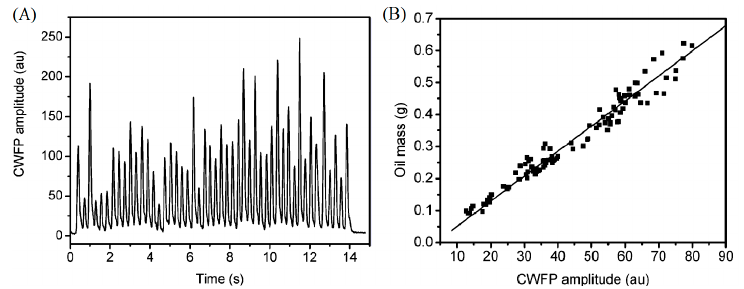
Figure 6. ( A ) CWFP signal amplitude corresponding to 48 macadamia nut fragments with oil masses ranging from 0.1 to 0.7 g. ( B ) Oil mass as a function of CWFP peak amplitude for macadamia nut fragments with oil masses ranging from 0.1 to 0.7 g. A total of 96 peaks were obtained in a time of Copyright (2007), with permission from ACS Publications. 14 s. The linear regression determination coefficient was R 2 = 0.95. Adapted from Publication [32], Copyright (2007), with permission from ACS